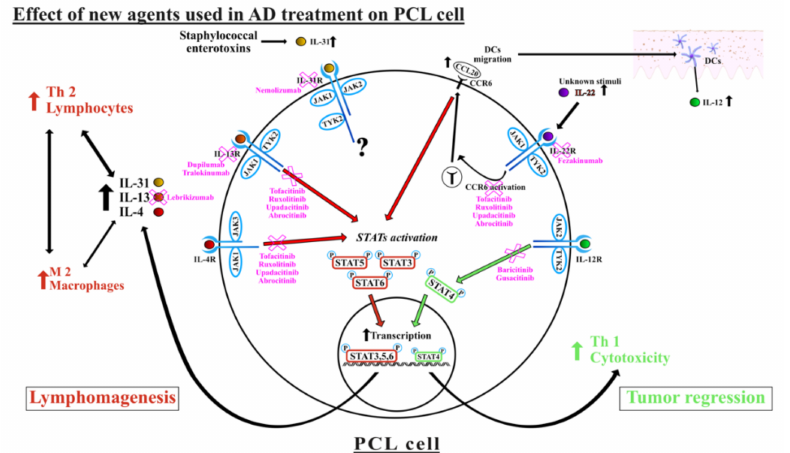
Figure 1. The influence of agents targeting interleukins (IL) 4, 13, 22, and 31 and JAK/STAT pathways on the primary cutaneous lymphomas (PCLs) cells and tumorous microenvironment. The up and down arrows stand for increase/decrease of the interleukins concentration, cell count or receptor’s upregulation. IL-12 promotes phosphorylation of STAT4, thereby stimulating the cytotoxic mediated CD8(+) answer. Concomitantly, IL-4, IL-13, and IL-31 contribute to forming the Th-2 cytokine profile, which results in decreased cytotoxic immunosurveillance and lymphomagenesis. IL-4, IL-13, and IL-22 activate different Janus kinases, which promote the STAT3, STAT5, and STAT6 activation contributing to the transcription of pro-tumorous factors. In the advanced stages of the disease, this phenomenon may be seen more prominently. By blocking several pathways or cytokines, biologic drugs and small molecule inhibitors may affect both the malignant microenvironment and pathways in the PCLs